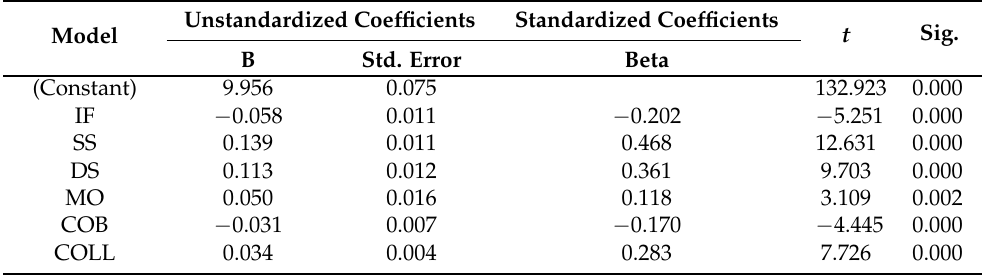
Table 6. Result of